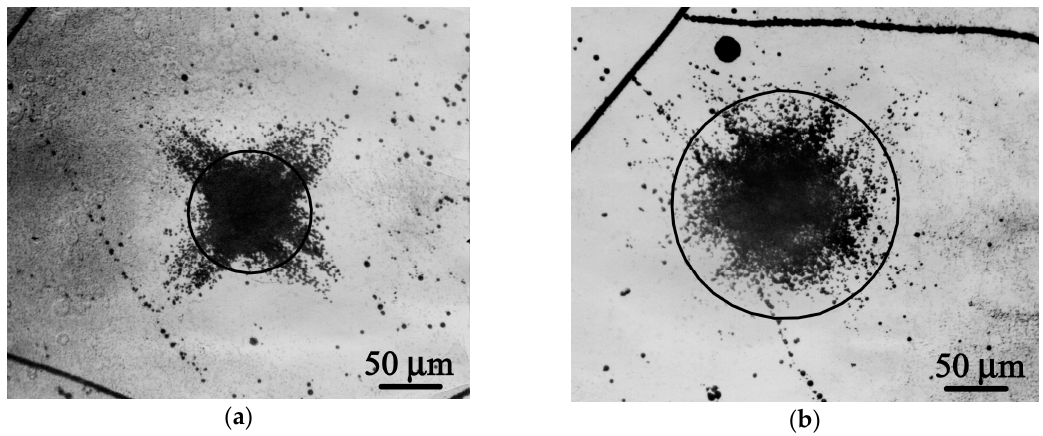
Figure 5. Dislocations around indentation print for single crystal Mo (001), revealed by etch pits method. The circles with radius b S are plotted on dislocation rosettes: ( a ) t = 20 ° C, HM = 1.998 GPa, b S = 47.7 μ m [34]; ( b ) t = 300 ° C, HM = 1.026 GPa, b S = 87.2 μ m, present work.